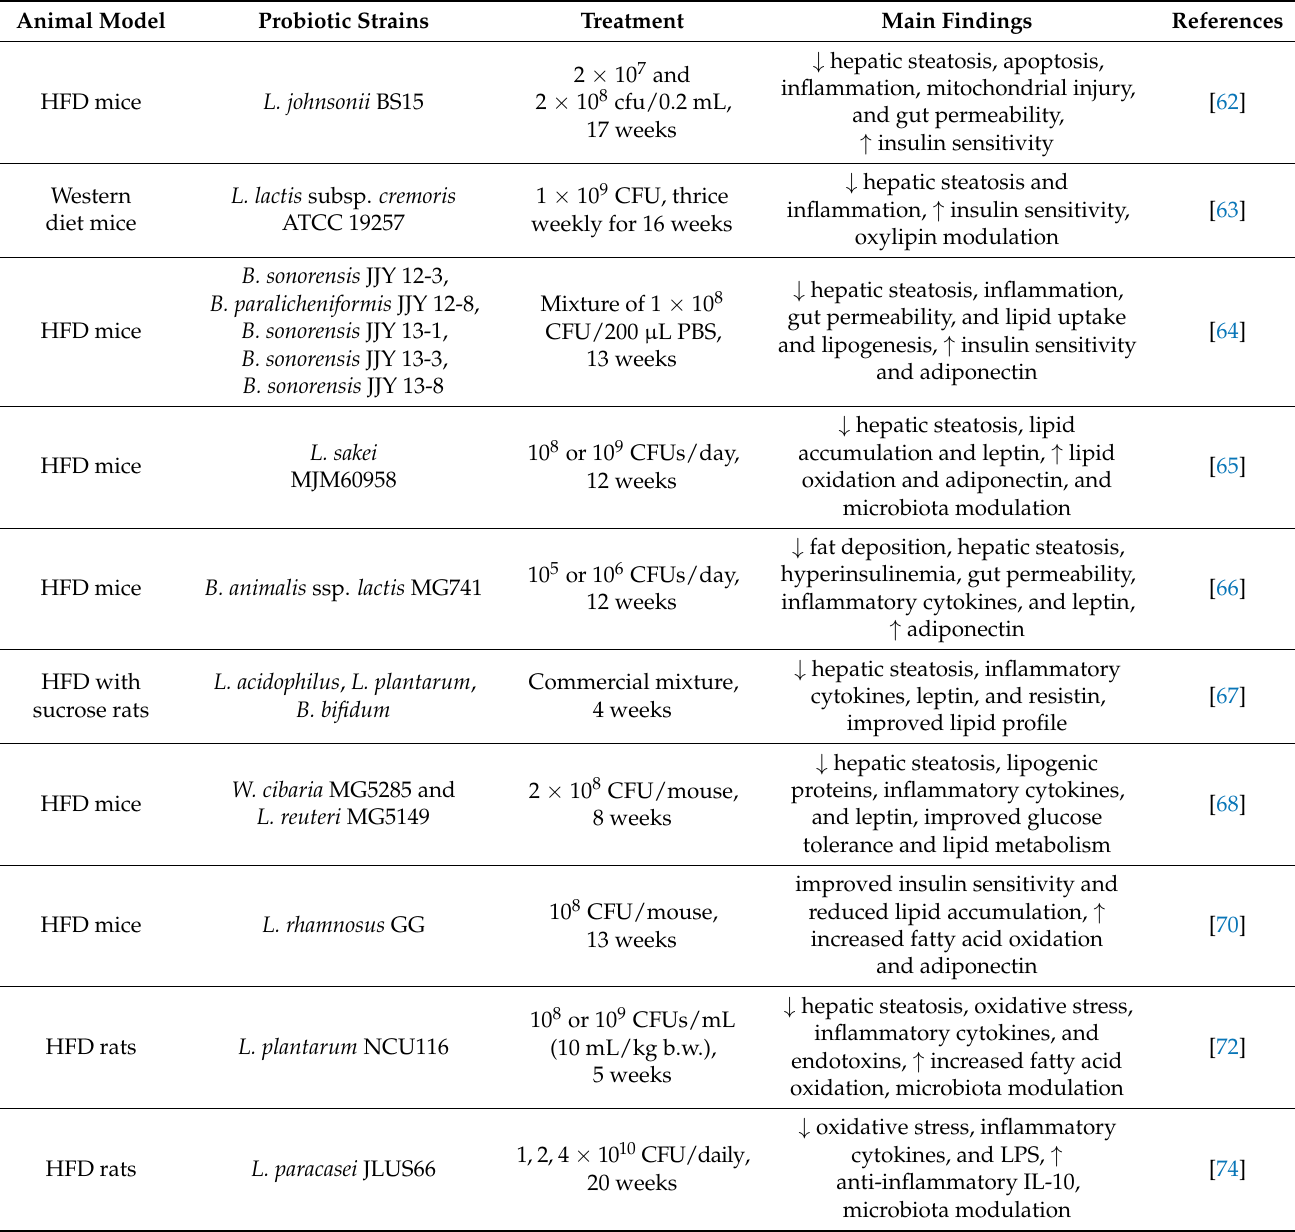
Table 1. Main results reported on the effects of probiotics in animal